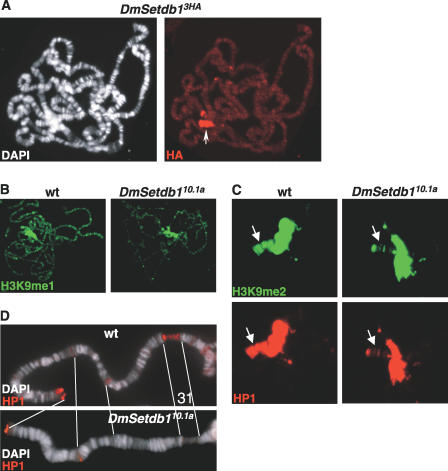
Localization of Endogenous DmSETDB1 and Comparison of H3K9me1, me2, and HP1 Pattern between Wild-Type and DmSetdb110.1a Homozygote Mutant(A) Salivary gland polytene chromosomes of DmSetdb13HA homozygous larvae were stained with α-HA. DNA is stained with 4′,6-diamidino-2-phenylindole (DAPI). DmSETDB1 localizes at Chromosome 4 (white arrows) and euchromatic arms. The chromocenter is also stained.(B) Salivary gland polytene chromosomes of wild-type (wt) and DmSetdb110.1a homozygous mutant (DmSetdb110.1a) were immunostained with α-H3K9me1. In the mutant, the H3K9me1 signal persists at the chromocenter but is weaker on the euchromatic arms when compared to wild type.(C) Immunostaining with antibodies recognizing H3K9me2 or HP1. Pictures were taken at higher magnification. White arrows show the Chromosome 4 arm. In the DmSetdb110.1a homozygous mutant H3K9me2 and HP1, signals are lost on most of Chromosome 4 arm but not at chromocenter or telomere.(D) Immunostaining with a α-HP1 is shown. DNA is stained with DAPI. Pictures were taken at higher magnification and show chromosome 2R arm. The region 31 is bound by HP1 in wild-type condition but not in DmSetdb110.1a homozygous mutant. Telomere is bound by HP1 in both genetic backgrounds.